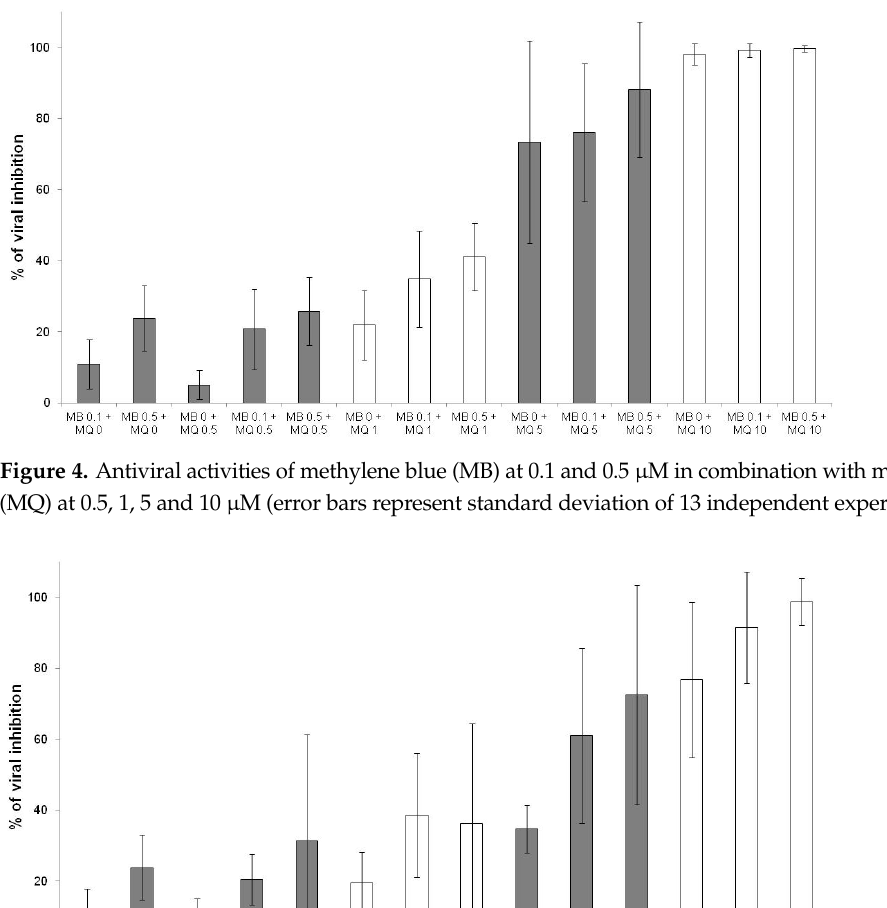
Figure 3. Antiviral activities of methylene blue (MB) at 0.1 and 0.5 µM in combination with quinine (QN) at 1, 5, 10 and 25 µM (error bars represent standard deviation of 13 independent experiments).